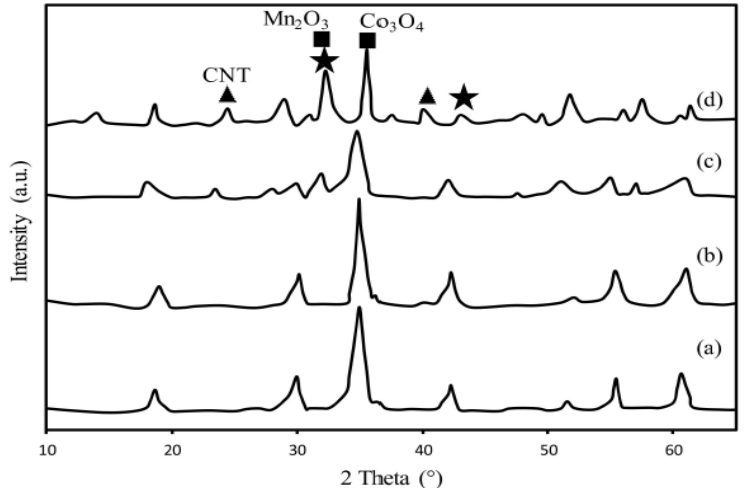
Figure 8. XRD profile of Co–Mn/CNT with Mn content ( a ) 5, ( b ) 10, ( c ) 15 and ( d ) 20%.